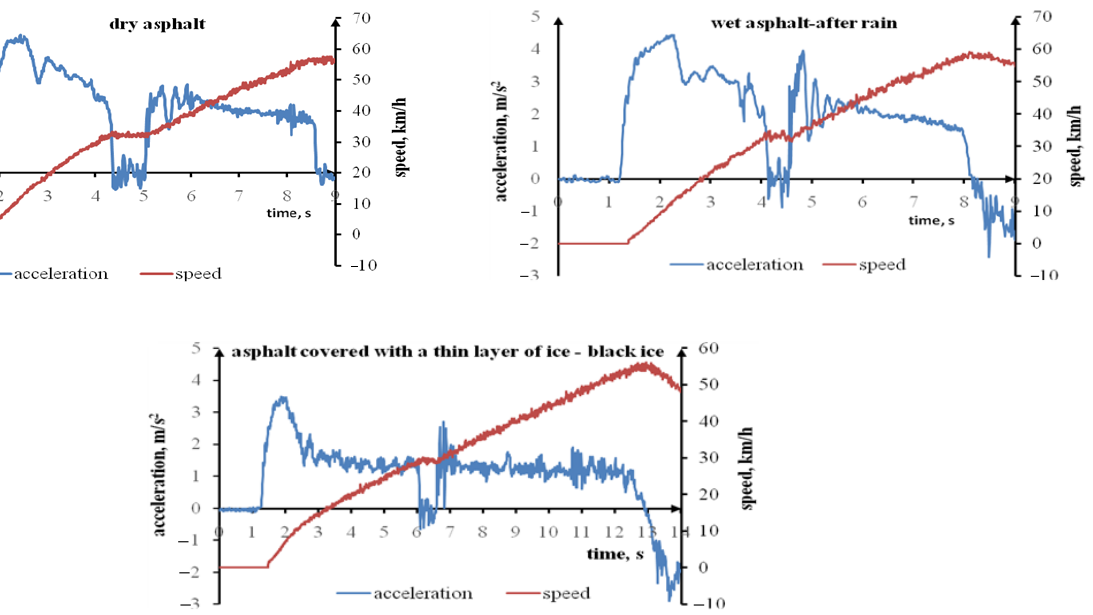
Figure 5. An example of the Ford Transit’s acceleration and speed during rapid acceleration on a dry surface, a wet (after rain) asphalt surface, and an asphalt surface covered with a thin layer of ice. Table 9. The Ford Transit’s selected motion parameters during rapid acceleration on a dry surface, a wet (after rain) asphalt, and asphalt covered with a thin ice layer.